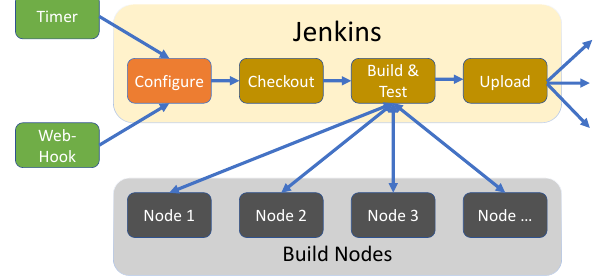
Figure 2. Overview of the LHCb Jenkins